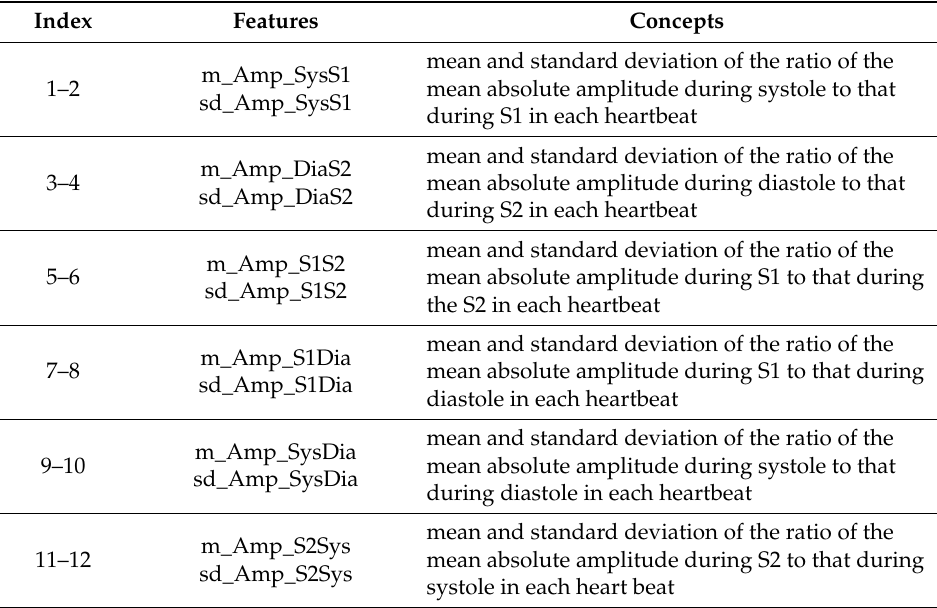
Table A2. The summary of the amplitude features extracted from four